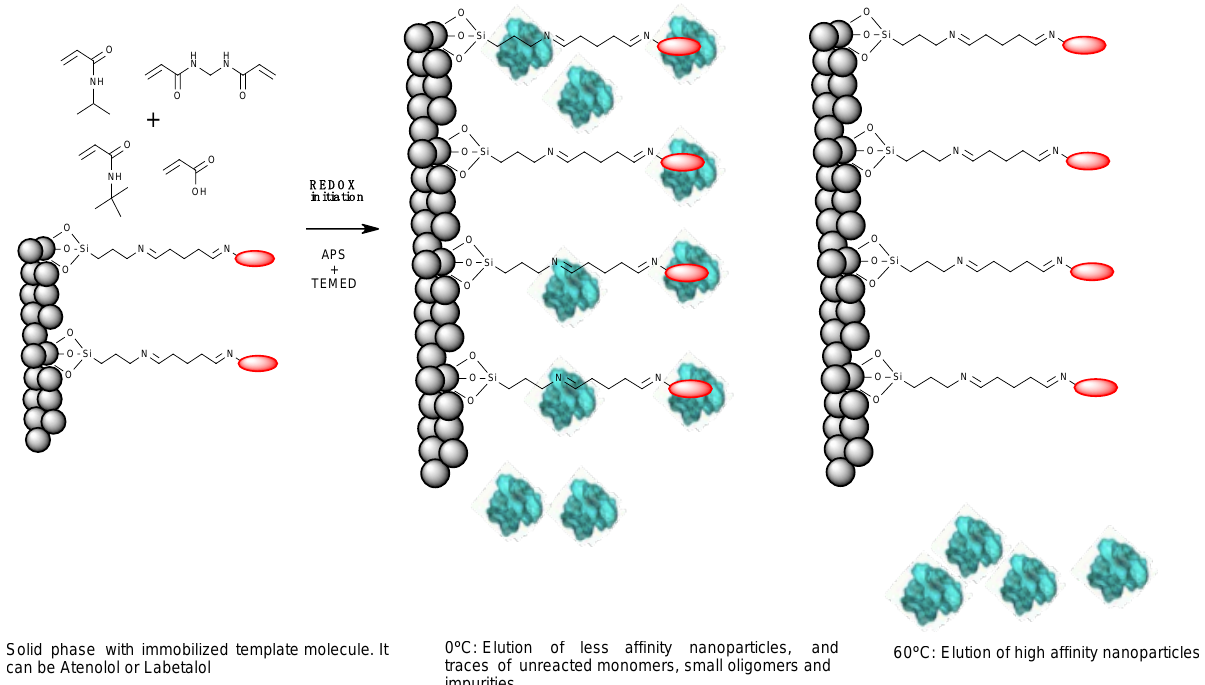
Figure 1. Schematic illustration of the synthesis of nanoMIPs in milli-Q water. The figure includes functionalized GBs, the mixture of monomers, the polymerization process, washing of solid-phase, and collection of high-affinity nanoparticles.